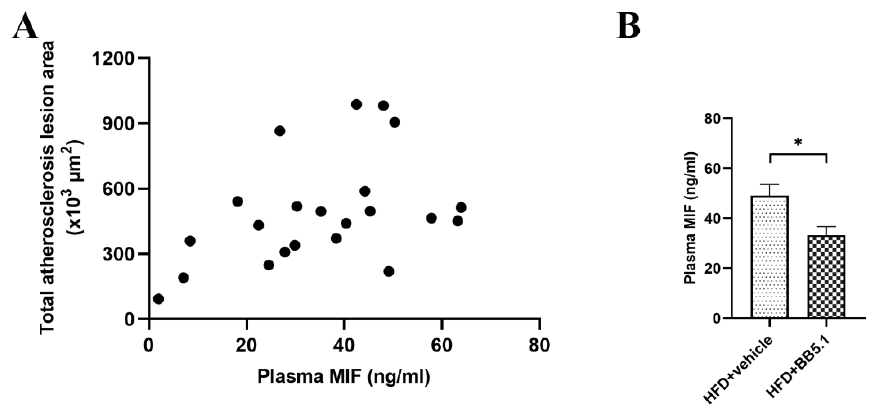
Figure 7. The levels of circulating MIF correlate with the size of atherosclerosis lesion and are reduced with anti-C5 treatment. ( A ) Spearman correlation between MIF concentration in plasma and the size of atherosclerosis plaque ( p = 0.033, ρ = 0.47). ( B ) Anti-C5 treatment reduced plasma MIF. Data are mean ± SEM. * p ≤ 0.05 HFD+vehicle vs. HFD+BB5.1.